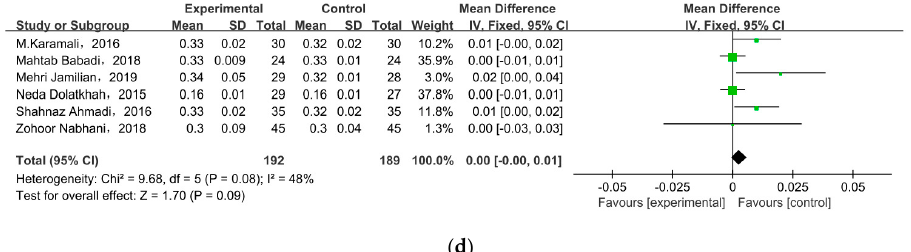
Figure 4. Effect of probiotic supplementation on glucose control in pregnant women with GDM: ( a ) FPG (mg/dL), ( b ) FSI (mU/L), ( c ) HOMA-IR, and ( d ) QUICKI. FPG: fasting plasma glucose; FSI: fasting serum insulin; HOMA-IR: the homoeostatic model assessment for insulin resistance; QUICKI: quantitative insulin sensitivity check index [21,22,27–35].